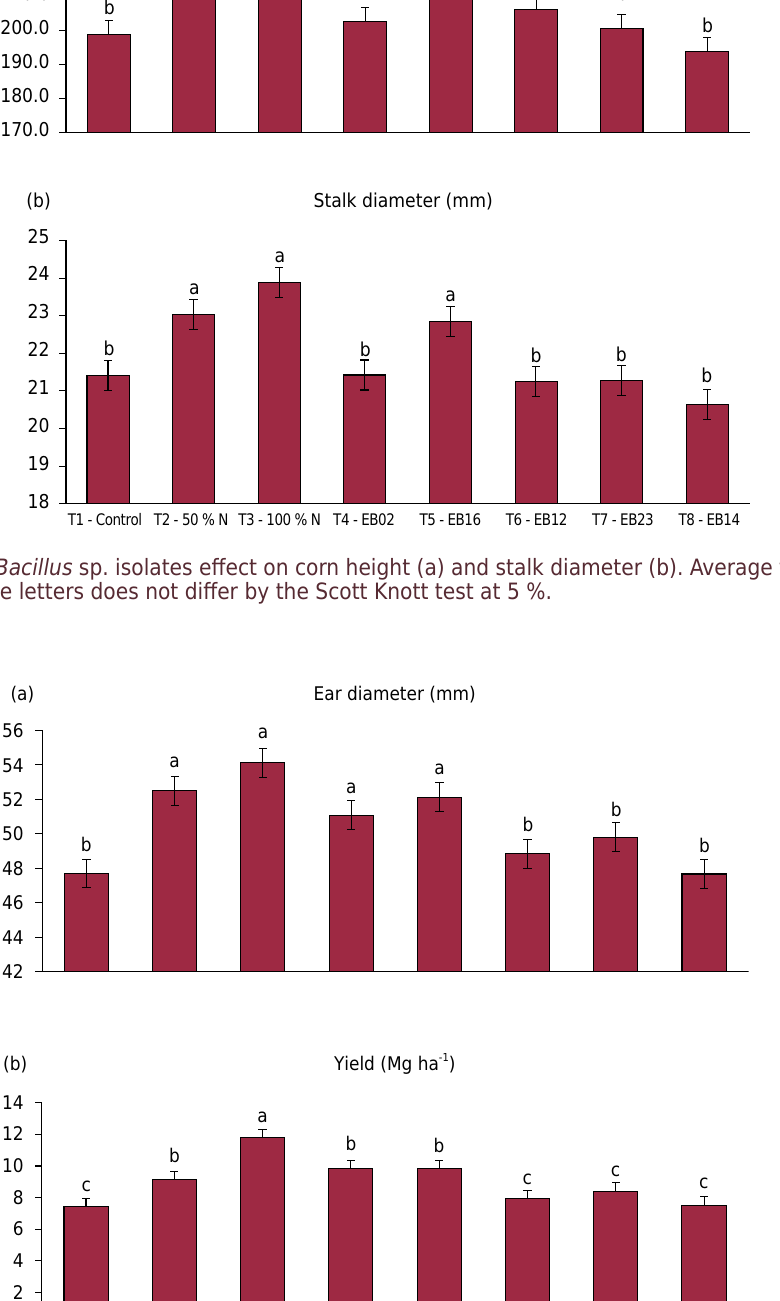
Plant growth mechanisms of Bacillus sp. isolates From the 27 isolates, 81.5 % (22) could solubilize calcium phosphate (Table 4). Among them, 16 isolates (59 %) showed solubilization halo in all replications, from the first day of observation. Nine isolates had IS greater than 1.0 (EB02, EB03, EB04, EB10, EB17, EB19,